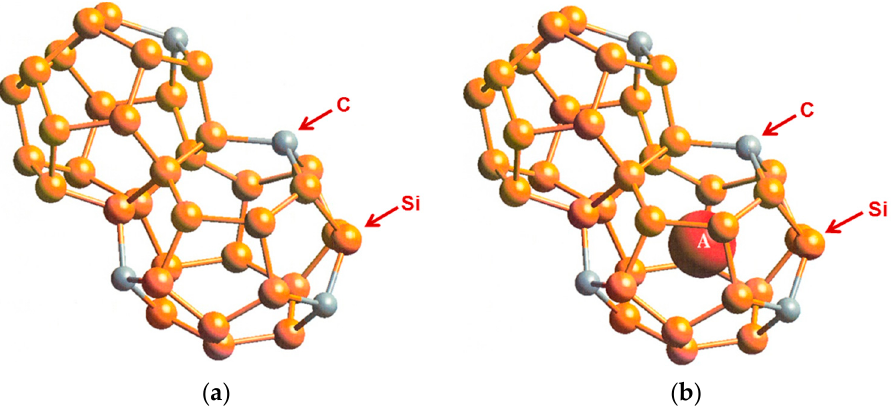
Figure 2. Cage structure of Type I carbon–silicon clathrate, C y Si 46-y ( a ) without guest atoms and ( b ) with x number of guest atoms A residing within the cage. From Chan et al. [8]. Reprinted with permission from Springer.